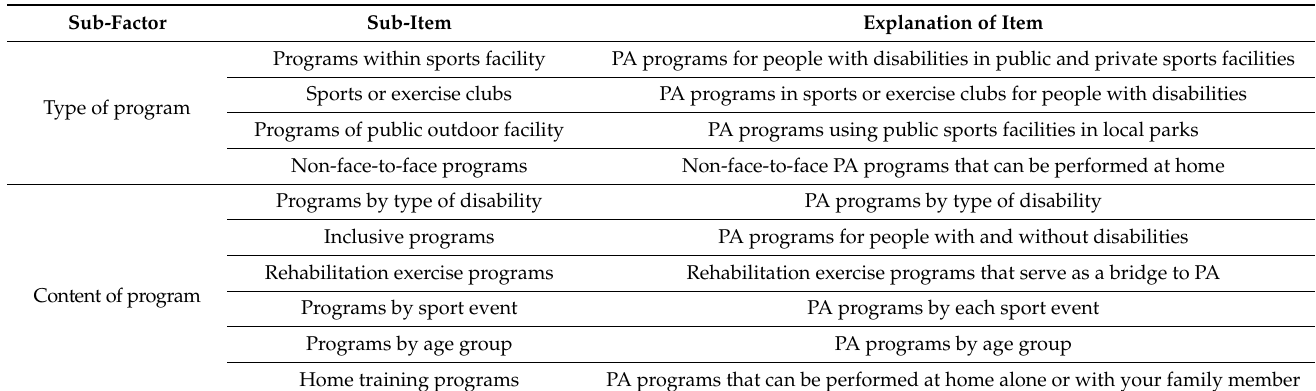
Table 8. Explanation of H4 by the program in